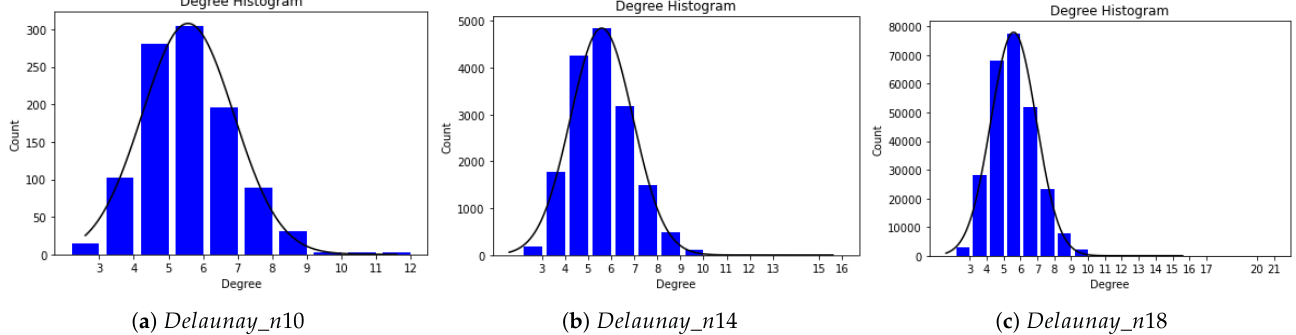
Figure 5. Normal distribution graphs.